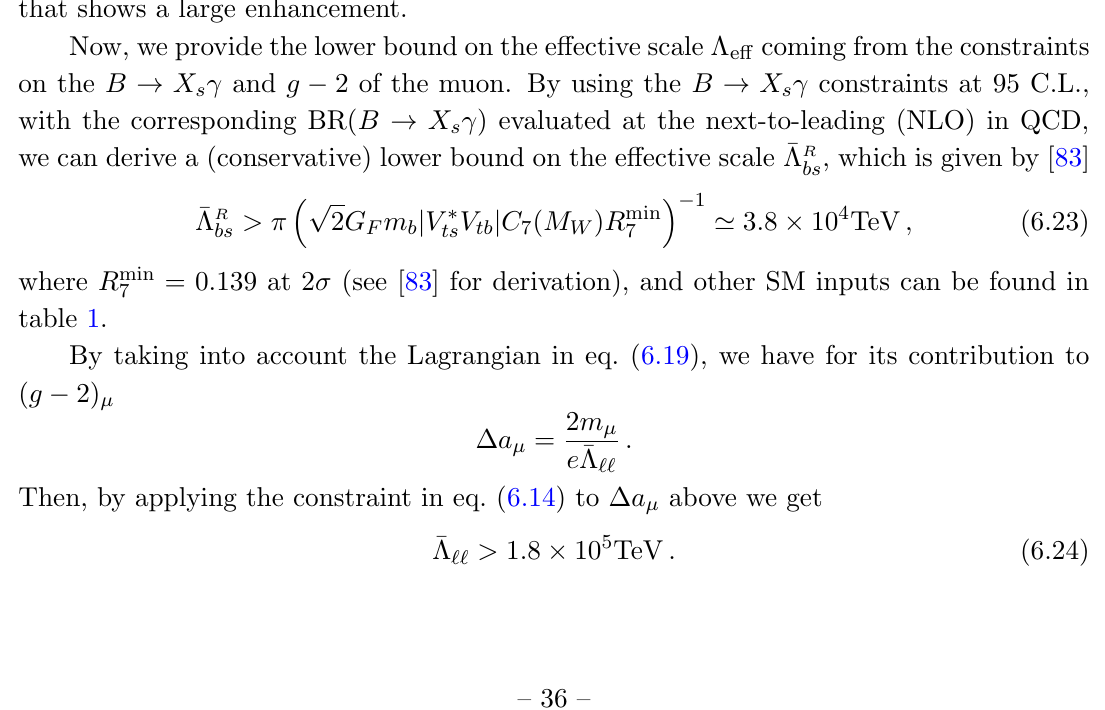
Figure 11 . Plots of the function F corresponding to the ratio R ( x; (cid:24) ) = f 2 ( x;(cid:24) ) functions f 2 and (cid:22) f 2 associated to the magnetic-dipole scales for dark-photon ((cid:22) (cid:13) ) and photon ( (cid:13) ) respectively, versus x = m 2 =m 2 , with m Q and m S the dark fermion and average messenger mass Q S respectively. Plots correspond to the representative value of the mixing parameter (in the messenger mass sector) (cid:24) = 1 2